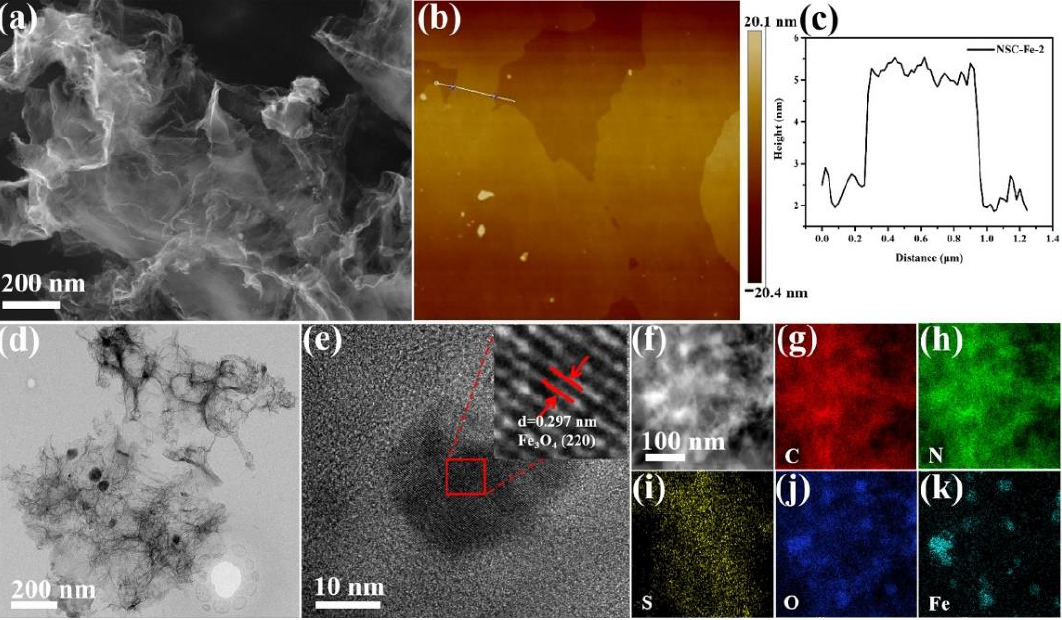
Figure 3. SEM image of ( a ) NSC-Fe-2, ( b ) AFM image of NSC-Fe-2, and ( c ) corresponding thickness; ( d ) TEM images of NSC-Fe-2, ( e ) HRTEM images of NSC-Fe-2, and ( f – k ) element mapping images of NSC-Fe-2. The inset of (e) is the corresponding lattice.